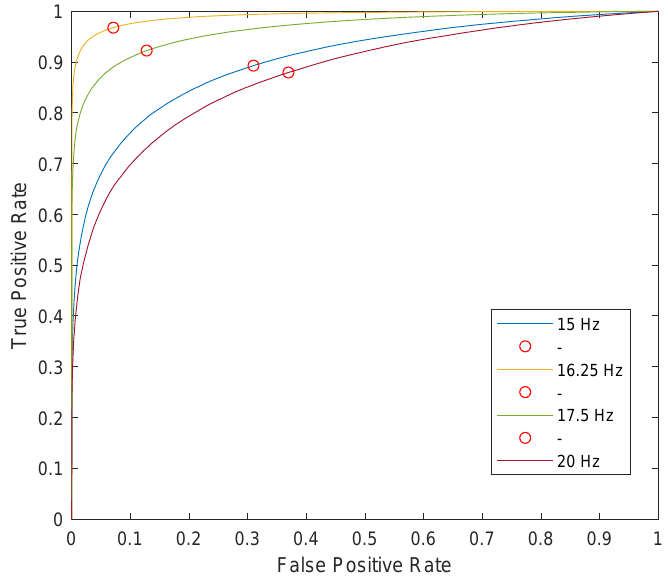
Figure 12. ROC curve for the Mahalanobis distance-based classification